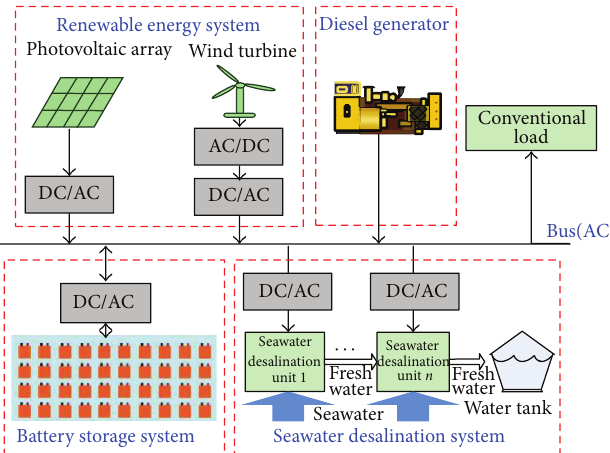
Figure 1: Structure of the island microgrid